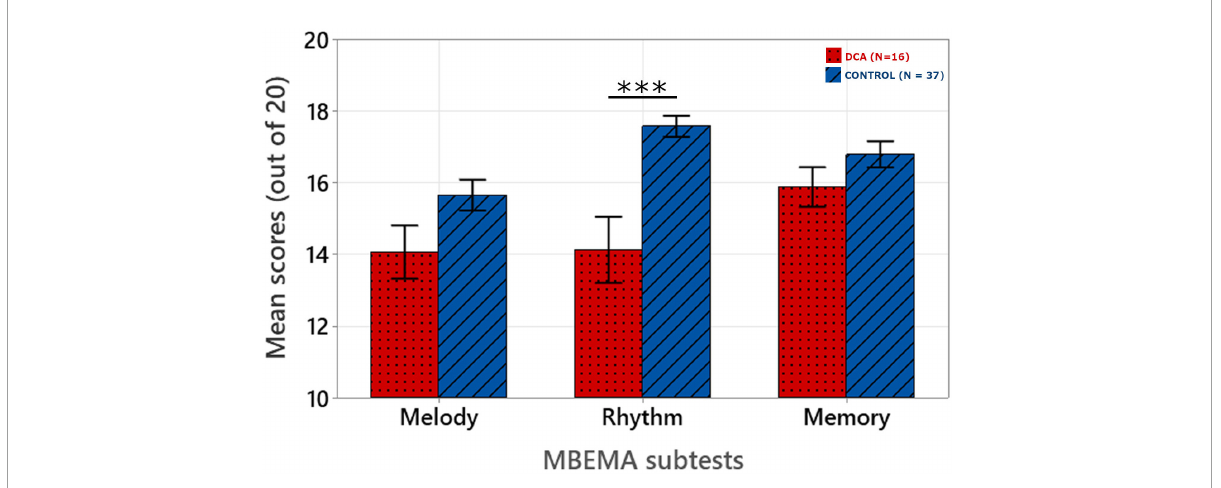
FIGURE1 Mean scores obtained for each subtest of the MBEMA. Origin is set at chance level (10/20). The error bars correspond to the standard error of the mean. ∗∗∗ p < 0.001.